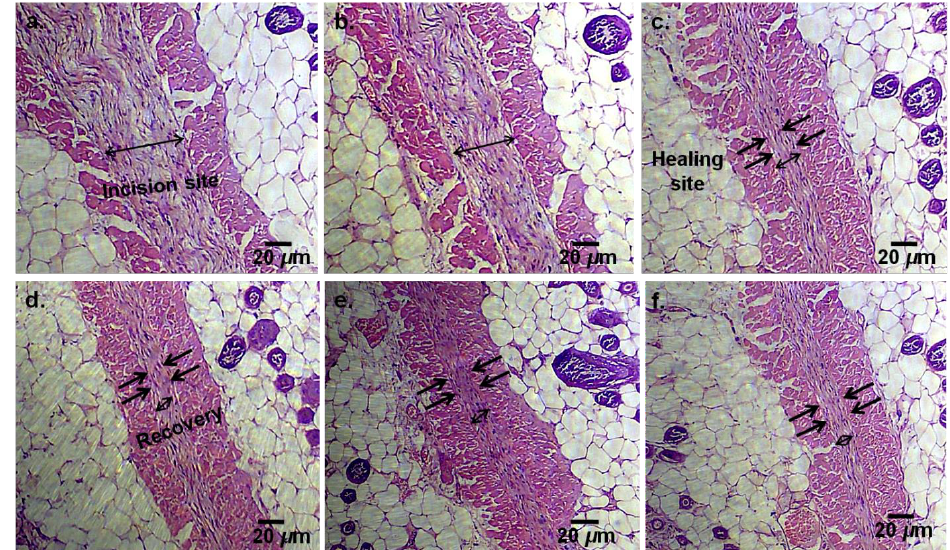
Figure 5. Histological (H&E staining) analysis obtained from the skin tissue area of the wound surface recovered after 7 days of treatment. Photomicrographs obtained from H&E staining of the skin wound area on day 7: ( a ) bare PP film, ( b ) dye (ICG)-loaded PP film, ( c ) lidocaine-loaded PP film, ( d ) neomycin-loaded PP film, ( e ) standard Band-Aid film, and ( f ) neomycin-loaded PP film with 5 min of portable (50 W) mini-heater (45 °C) treatment. The arrows indicate wound healing sites and wound closure areas. The scale bars represent 20 µm.